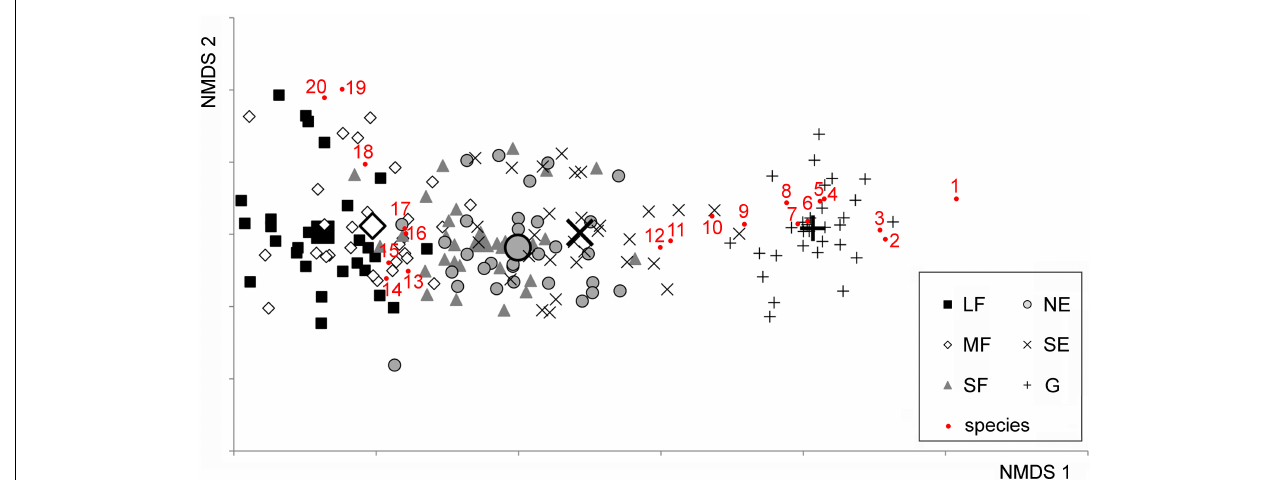
FIGURE 1 | Non-metric Multidimensional Scaling (NMDS) ordination scatterplot of the 176 plots. Only the top 20 species, according to the correlation to the ordination space (i.e., square root of the goodness of fit), are displayed. LF, large forest patches; MF, medium forest patches; SF, small forest patches; NE, north-facing edges; SE, south-facing edges; G, grasslands. The centroids for each habitat are drawn with larger signs. Species are as follows: 1, Kochia laniflora ; 2, Erophila verna ; 3, Alkanna tinctoria ; 4, Crepis rhoeadifolia ; 5, Polygonum arenarium ; 6, Holosteum umbellatum ; 7, Poa bulbosa ; 8, Syrenia cana ; 9, Arenaria serpyllifolia ; 10, Euphorbia seguieriana ; 11, Stipa borysthenica + capillata ; 12, Festuca vaginata ; 13, Ligustrum vulgare ; 14, Berberis vulgaris ; 15, Rhamnus catharticus ; 16, Celtis occidentalis ; 17, Crataegus monogyna ; 18, Bromus sterilis ; 19, Stellaria media ; 20, Anthriscus cerefolium .